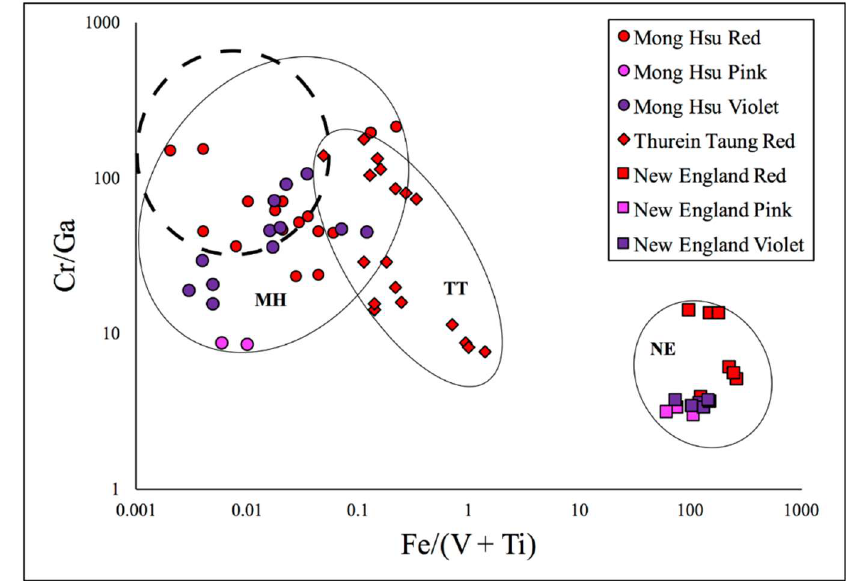
Figure 15. Ruby plots of Mong Hsu (MH), Thurein Taung (TT), Myanmar, and New England, East Australia (NE) are shown within oval enclosing field boundaries in a Cr/Ga vs. Fe/(V + Ti) diagram. The plots are color- and locality- coded to indicate multi-zoned crystals (top right legend). The Mong Hsu ruby field designated by Mittermayr et al. [66] is indicated by a dashed circle.